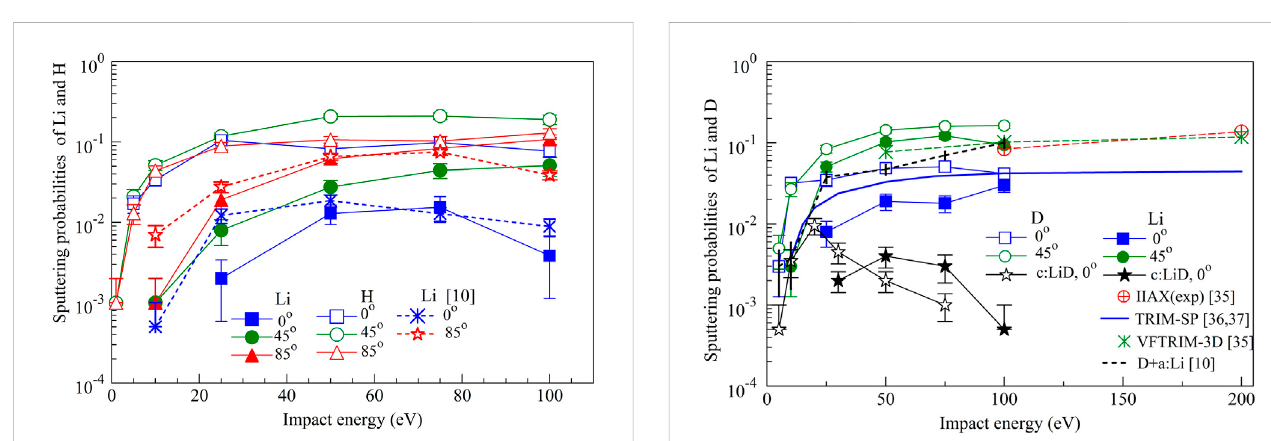
FIGURE 5 Sputtering probabilities of Li and D atoms per impact of D atom, for several impact angles, as functions of incident energy of D impact at a: LiD surface at 300 K. Comparison with available experimental and computational data from Refs. [35, 36] are also shown. The data in [35] are for Li sputtering by D impact at 45 o at lithium saturated by D. TRIM.SP data of [36, 37] are for D on a monoatomic Li